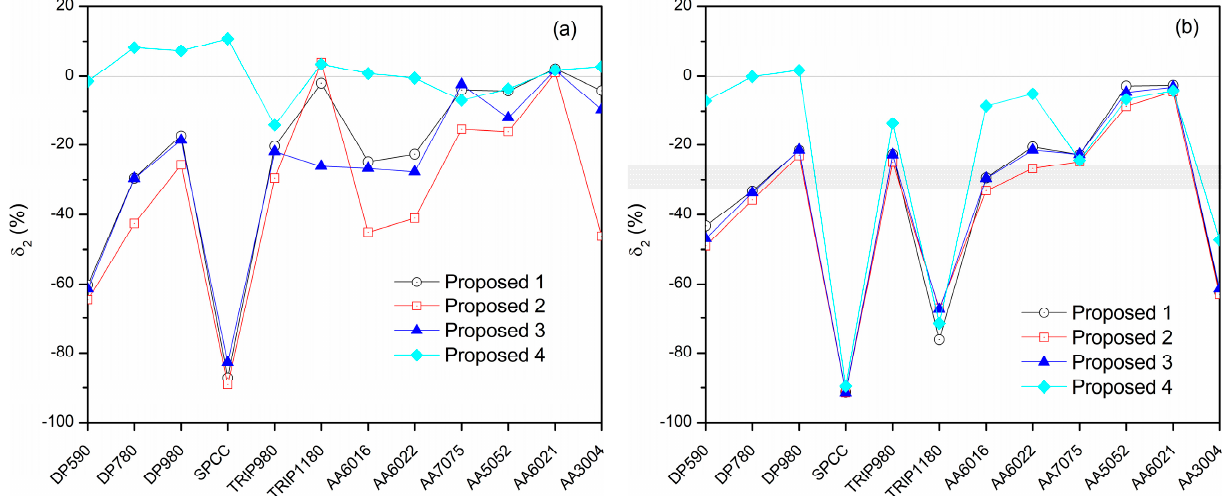
Figure 10. Calculated δ 2 of the identified hardening laws for tested materials. ( a ) Hardening laws identified by the common curve fitting method. ( b ) Hardening laws identified by the constrained curve fitting method.